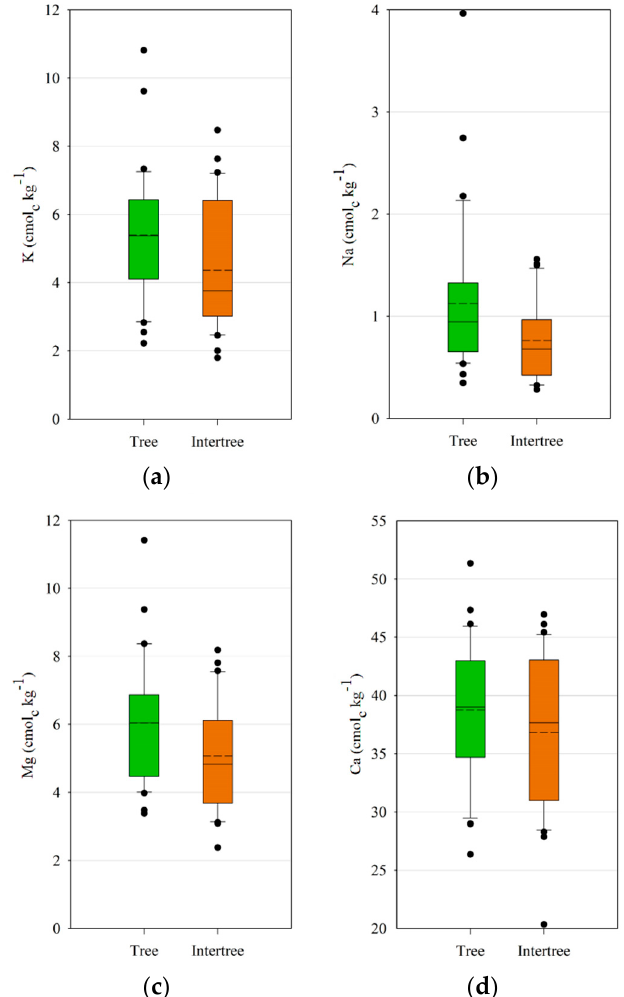
Figure 12. ( a ) Potassium (K) content ( p < 0.05), ( b ) sodium (Na) content ( p < 0.05), ( c ) magnesium (Mg) content ( p < 0.05), and ( d ) calcium (Ca) content (short dash: mean line, solid line: median,